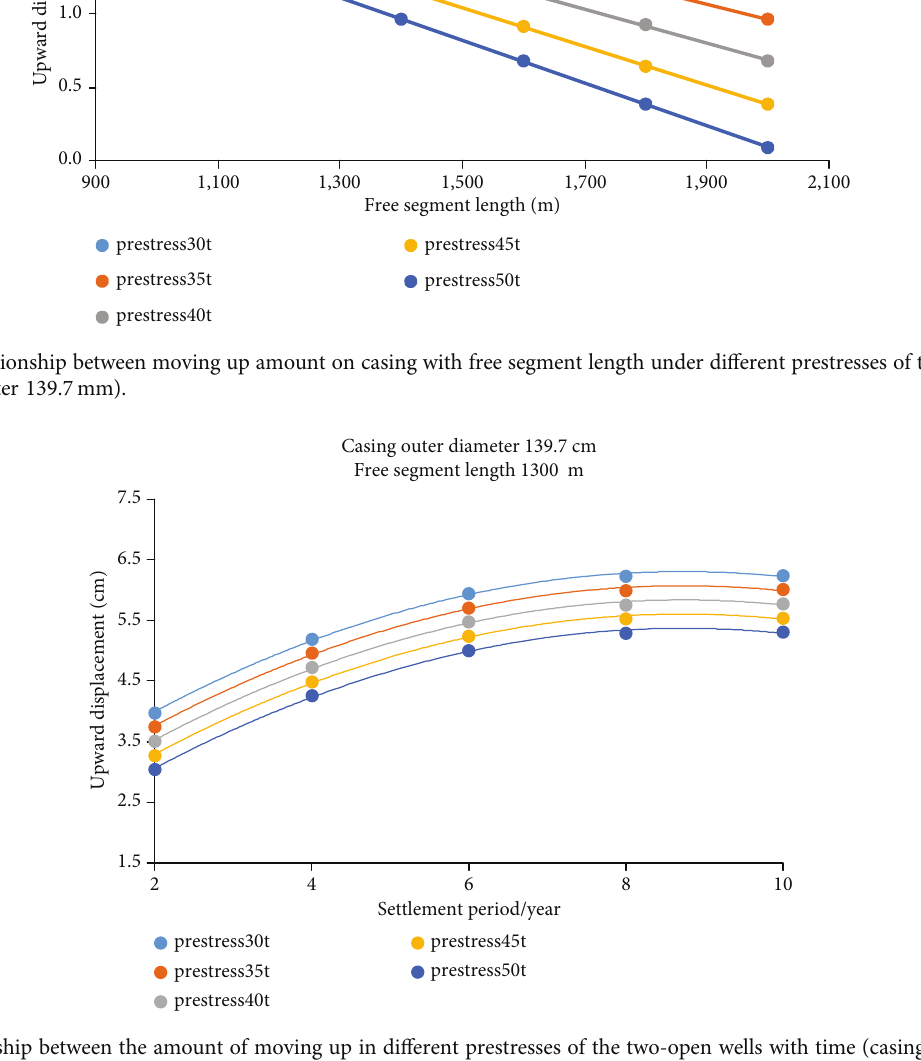
Figure 13: Relationship between the amount of moving up in di ff erent prestresses of the two-open wells with time (casing outer diameter